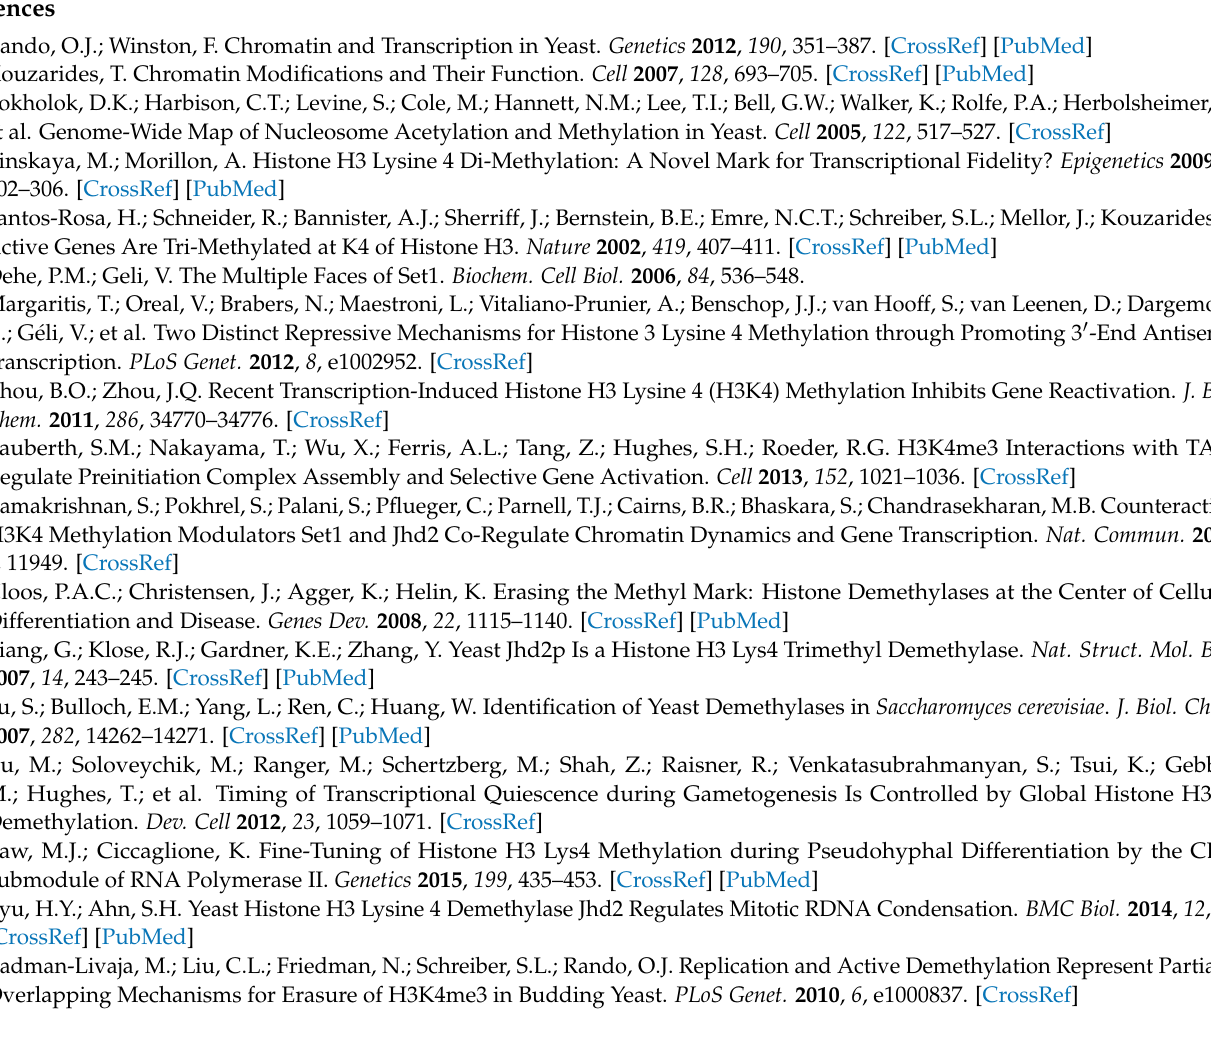
accumulation; Figure S4: Catalytical inhibition of Jhd2 causes an increase of H3K4 trimethylation and an early transcriptional induction of ODC1; Figure S5: Time course of repression of IDP2 and ODC1 after release from DS for the wild type BY4741 and the isogenic ∆ JHD2 strain; Figure S6: Set1 protein levels in Jhd2 absence; Table S1: RT-PCR primers sequences; Table S2: selected list of ChIP on chip results. Reference [19] is cited in Supplementary